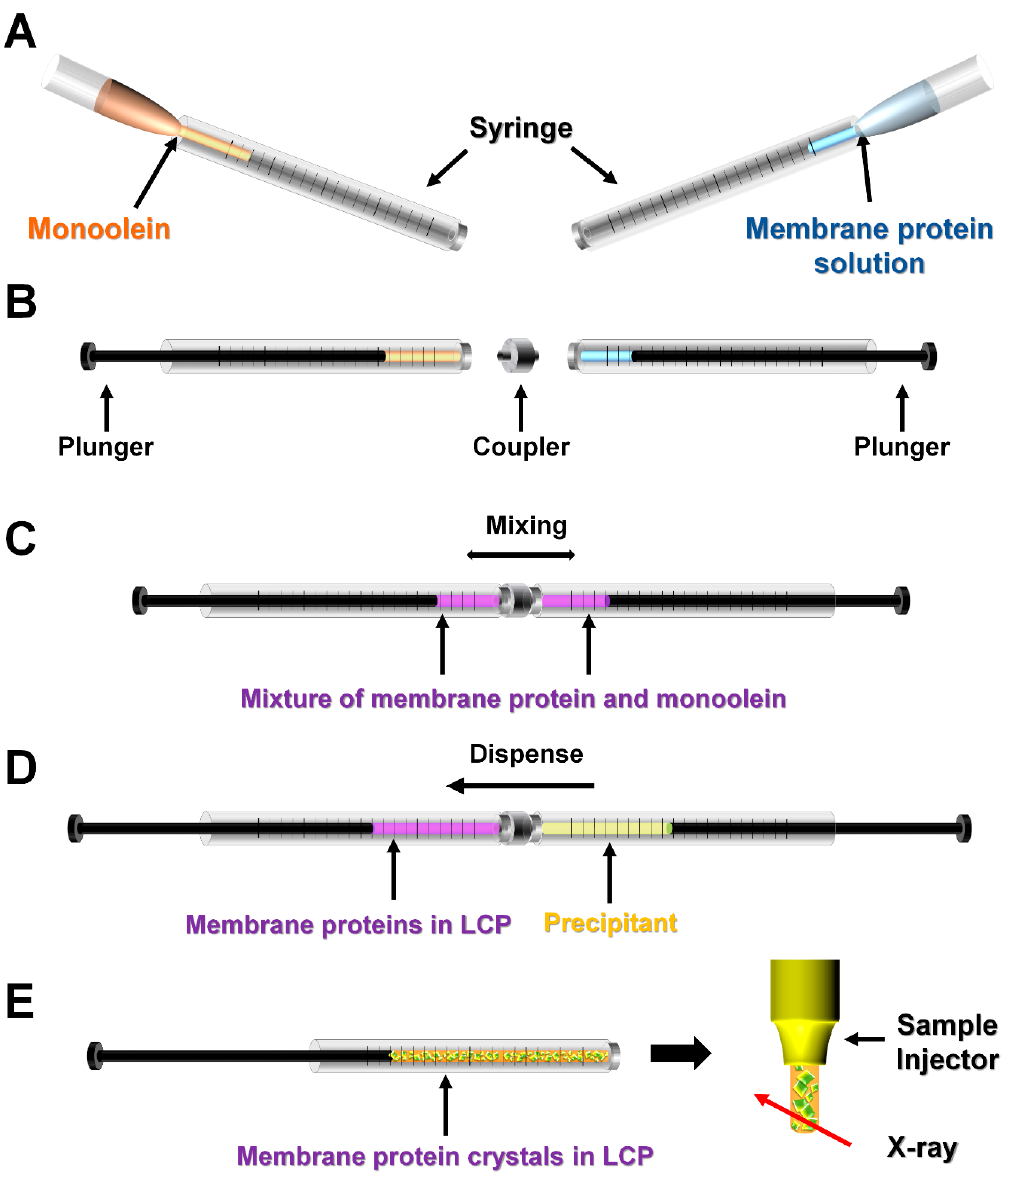
Figure 2. Crystal growth in delivery medium for serial crystallography. Example of crystallization of membrane protein in lipidic cubic phase (LCP). ( A ) Monoolein (9.9 MAG) as a delivery medium and membrane protein solution is injected into each syringe. The ratio of monoolein and protein solution